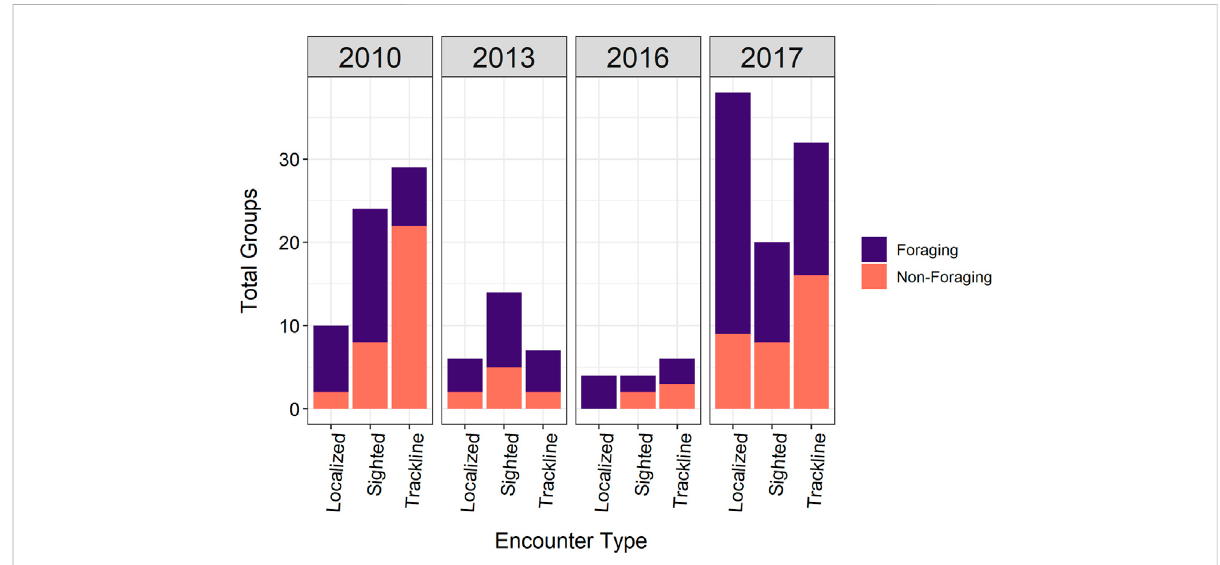
FIGURE 3 Total foraging and non-foraging groups for each encounter type per survey year included in the model data sets.